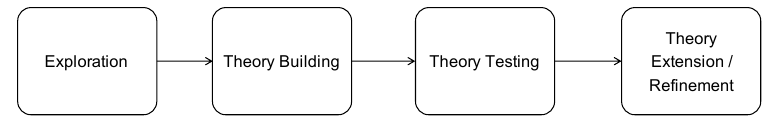
Figure 1. Methodological procedure (based on